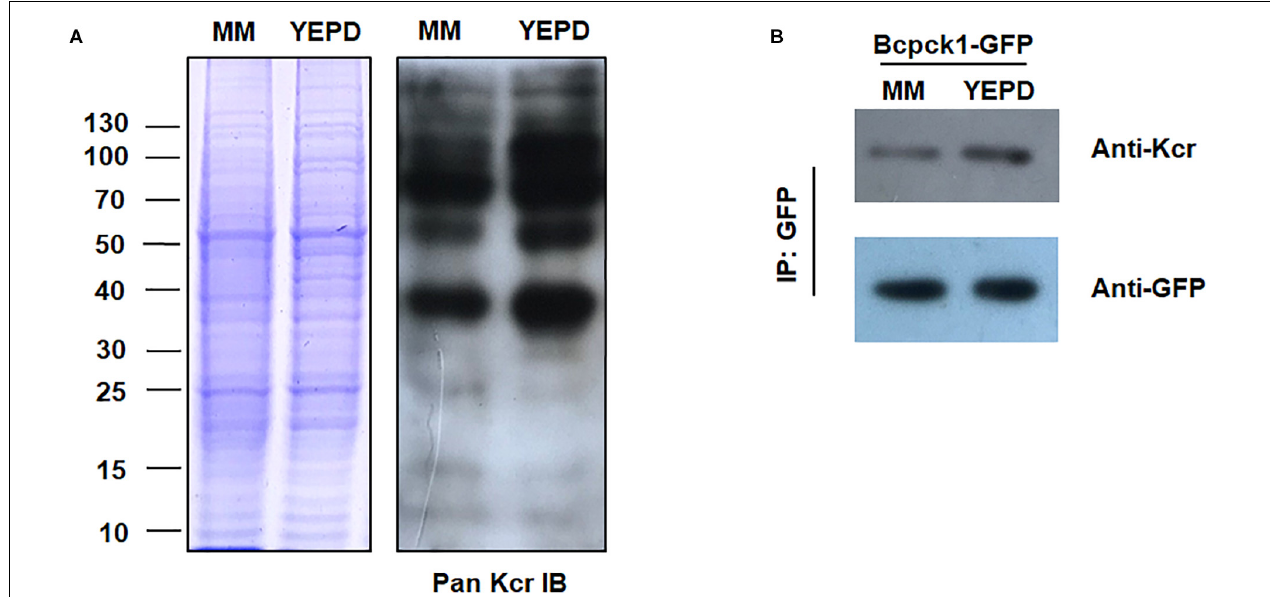
FIGURE 7 | Kcr levels of B. cinerea under different physiological conditions. (A) Immunoblot analysis of crotonylated proteins with pan anti-Kcr antibody of B. cinerea cultivated in liquid YEPD or MM. The loading control by Coomassie blue staining was used to ensure that equal amounts of protein were loaded in each lane. (B) Protein extracts containing Bcpck1-GFP were immunoprecipitated (IP) using anti-GFP beads. The isolated proteins were resolved by SDS-PAGE. Anti-GFP and anti-Kcr antibodies were used to detect Bcpck1-GFP and its crotonylated isoform, respectively.